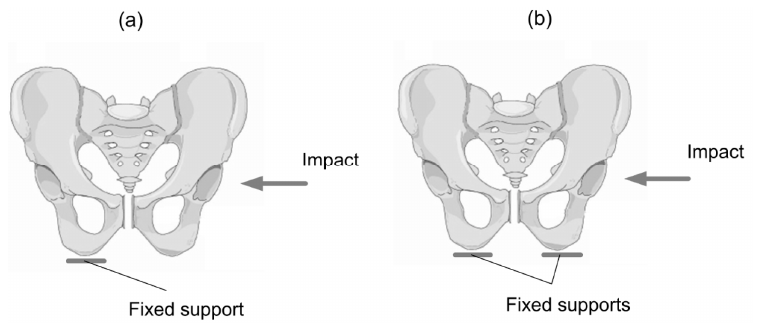
Figure 4. Two support configurations: ( a ) support on one pelvis bone on the opposite side than the impact support case I, ( b ) support on two pelvis bones support case II.